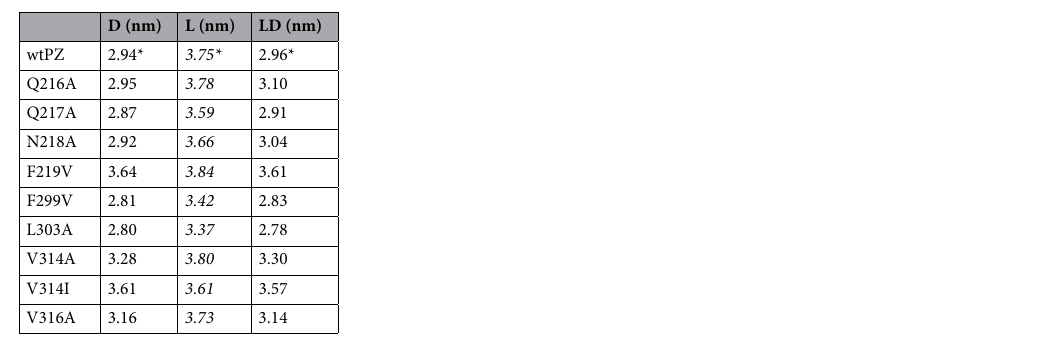
Table 1. R H of wtPZ and PZ mutants. *Data for wtPZ were taken from a previous study 16